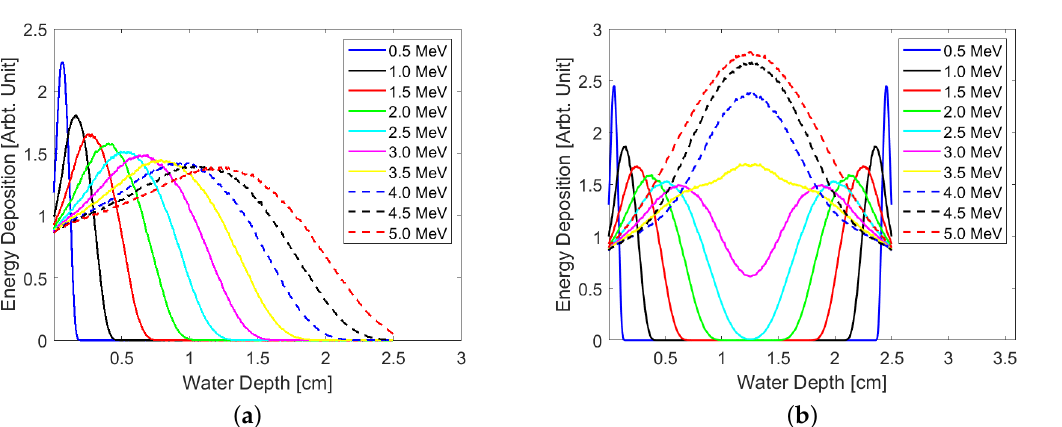
Figure 7. Energy deposition vs. water depth for different beam energies when irradiated from ( a ) one side and ( b ) both sides for an angle of incidence of 0 ◦ .